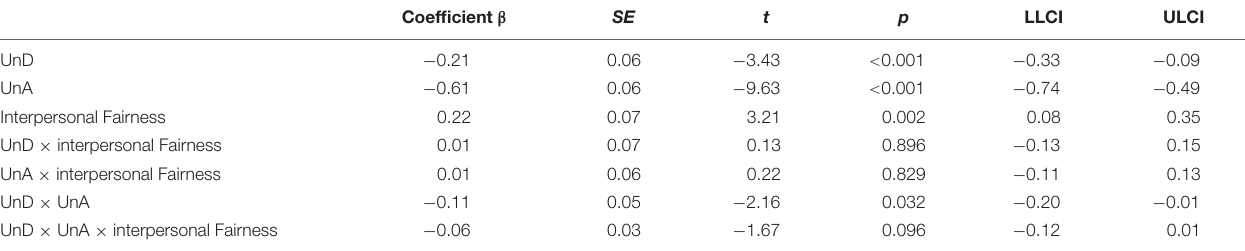
TABLE 5 | Effects of the moderated regression analysis including interpersonal fairness (Hayes, 2013, Model 3).